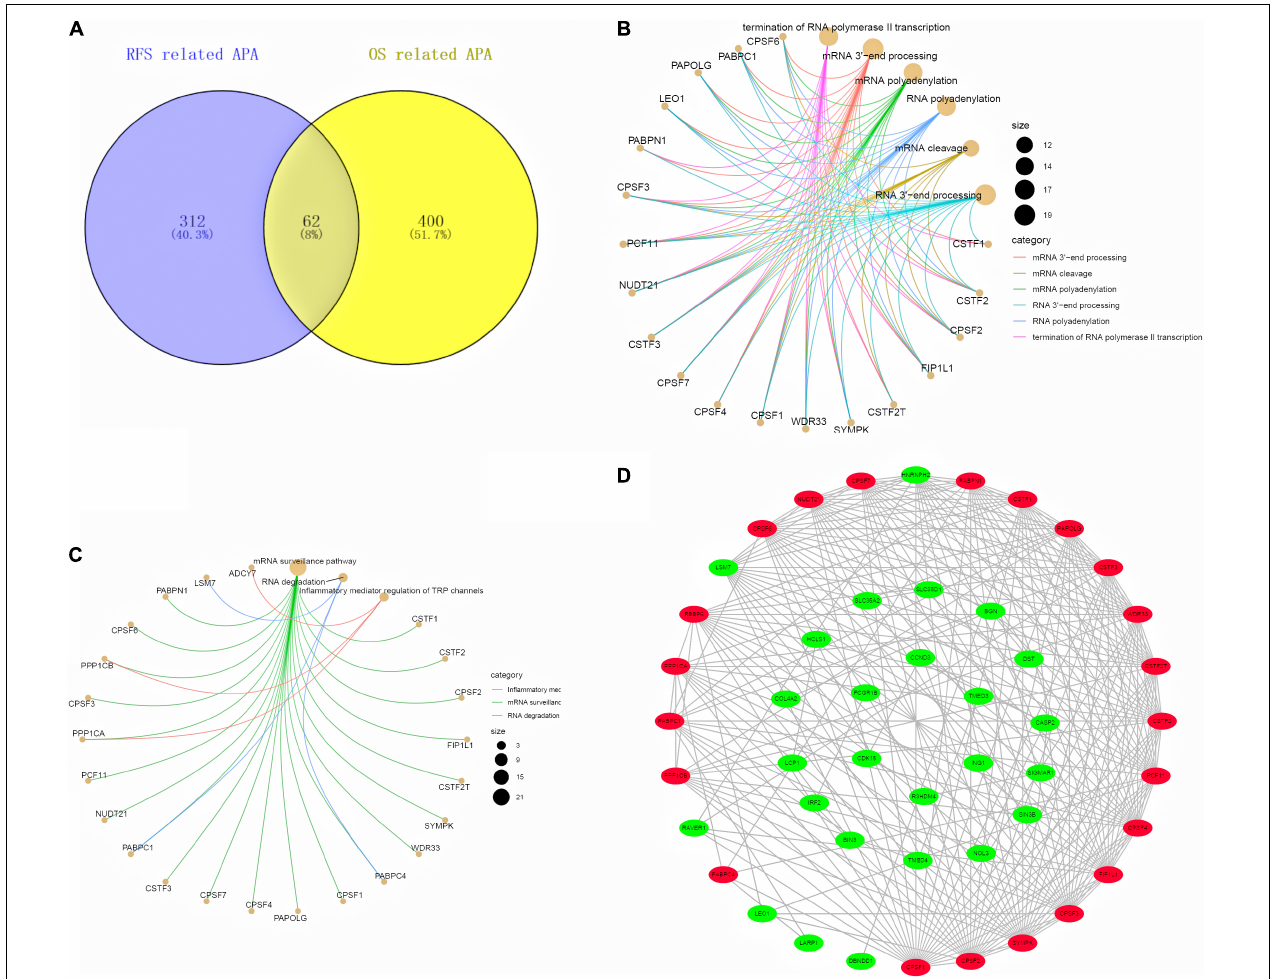
FIGURE 9 | Interaction network between the hub APA genes and CRs. (A) Venn diagram of the hub APA events in RFS-related APA events and OS-related APA events. (B,C) GO and KEGG analysis of the hub APA genes and CRs. (D) PPI network of the hub APA genes and